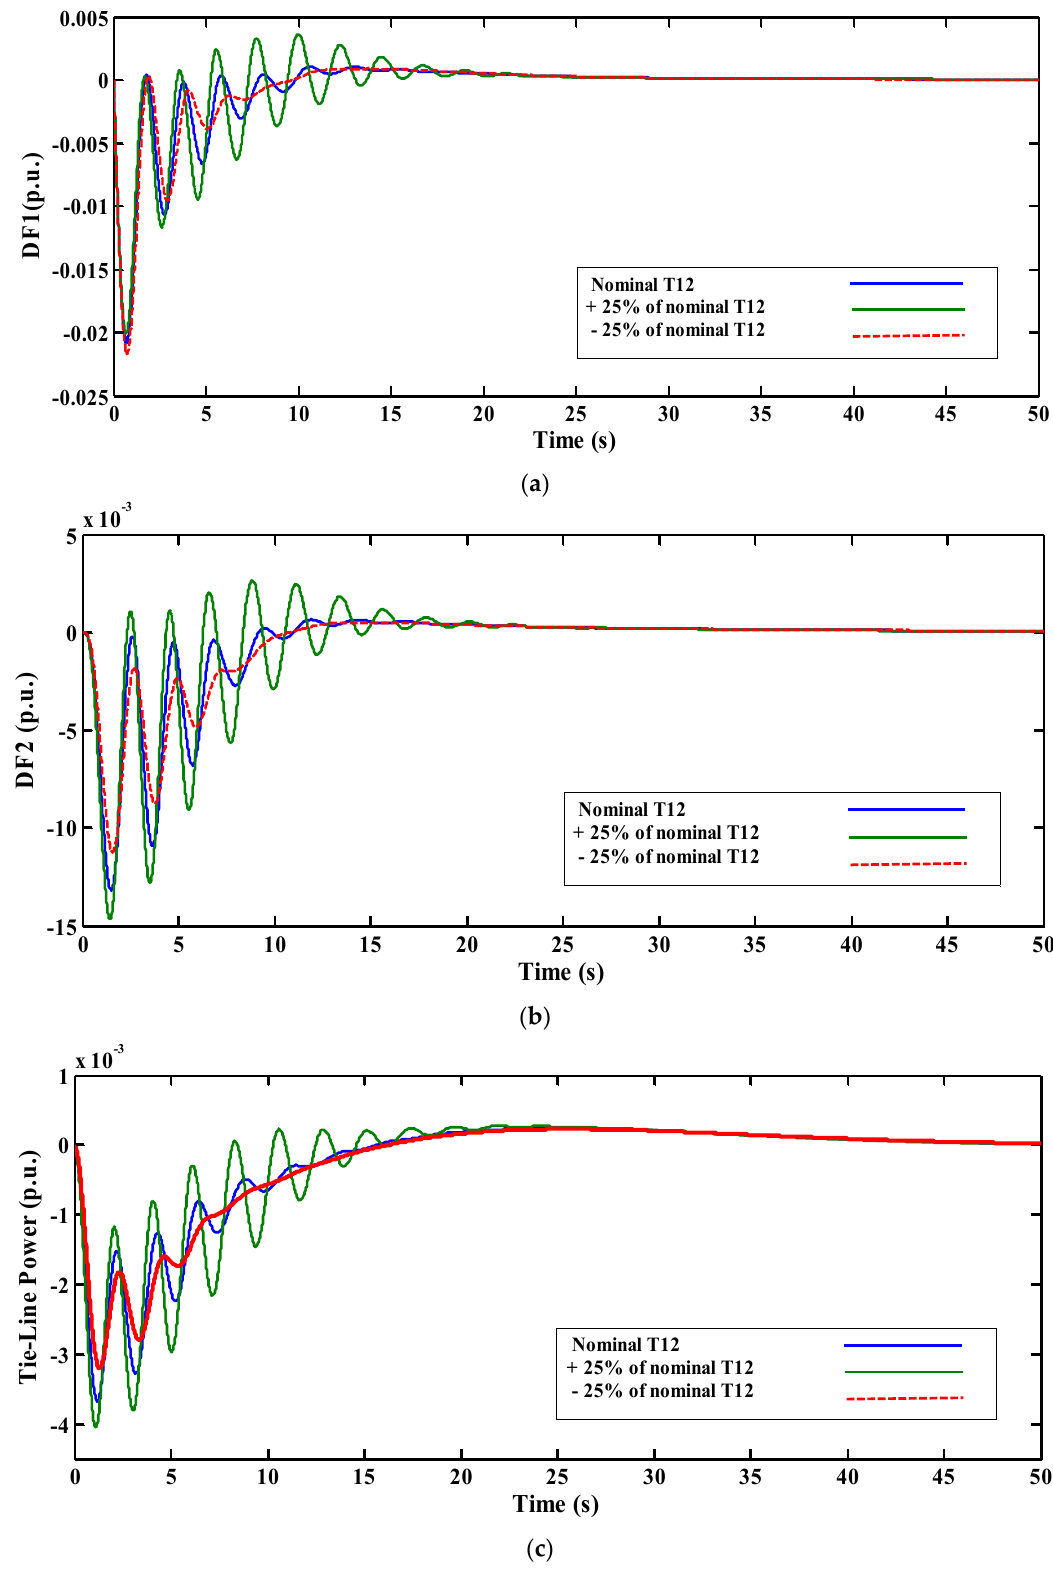
Figure 8. Simulation results for ± 25% of synchronizing coefficient, ( a ) frequency deviation in area 1; ( b ) frequency deviation in area 2; and ( c ) tie ‐ line power deviation.